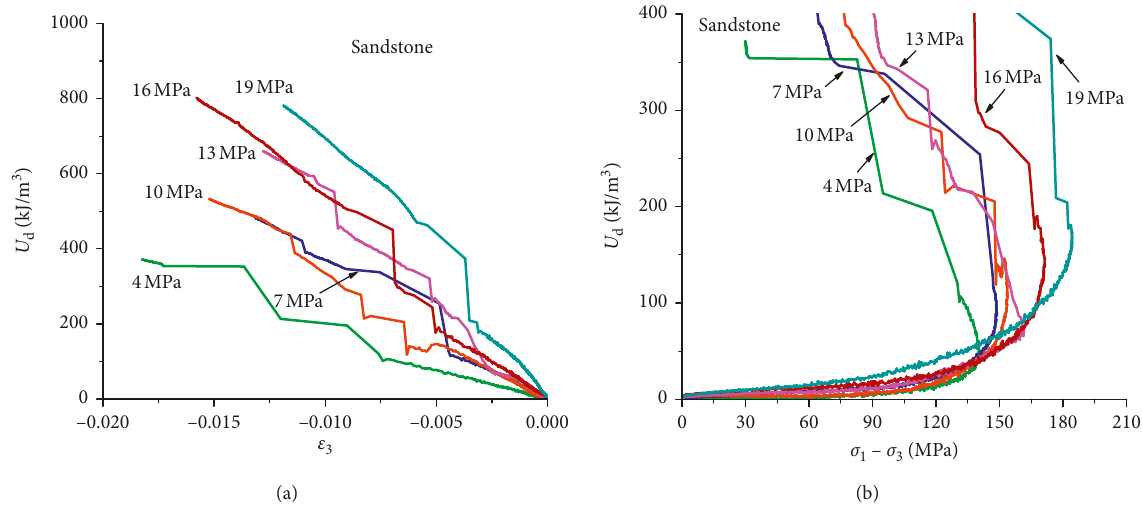
Figure 7: Comparison of dissipated energy curves under different confining pressures. (a) Dissipative energy-radial strain curve. (b) Dissipated energy-deviation stress